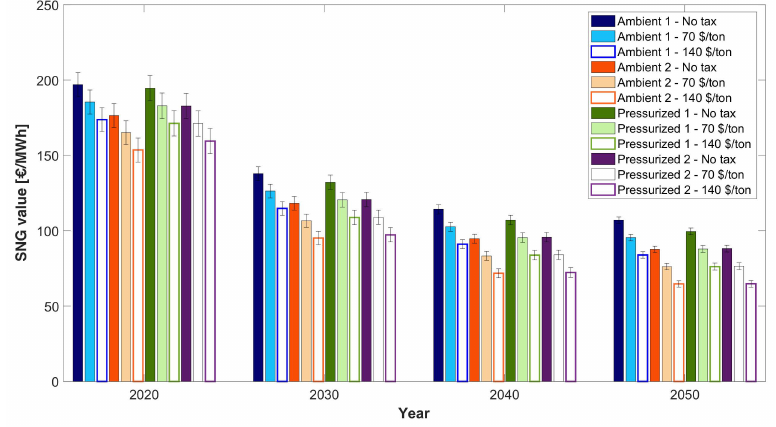
Figure 13. SNG value evolution due to the SOEC cost development and carbon tax introduction.